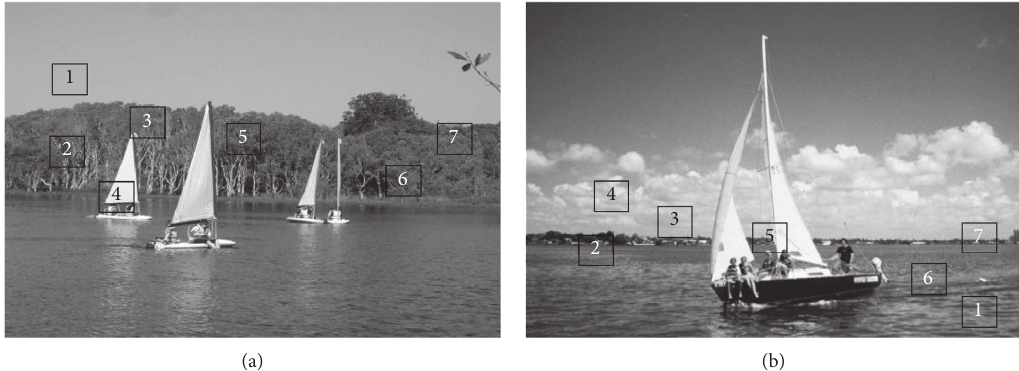
Figure 4: Sparsity of the sample block structure of the image to be repaired. (a) Image 1 to be repaired. (b) Image 2 to be